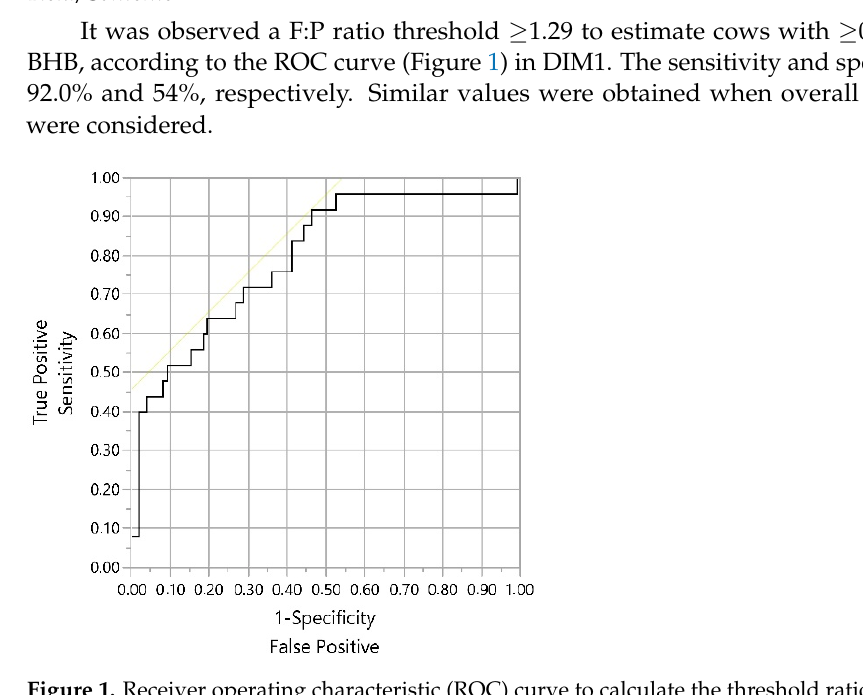
Figure 1. Receiver operating characteristic (ROC) curve to calculate the threshold ratio F:P to predict hyperketonemia (subclinical ketosis). Positive level: beta-hydroxybutyrate ≥ 0.14 mmol/L; p < 0.001; AUC (area under the curve) = 0.80.